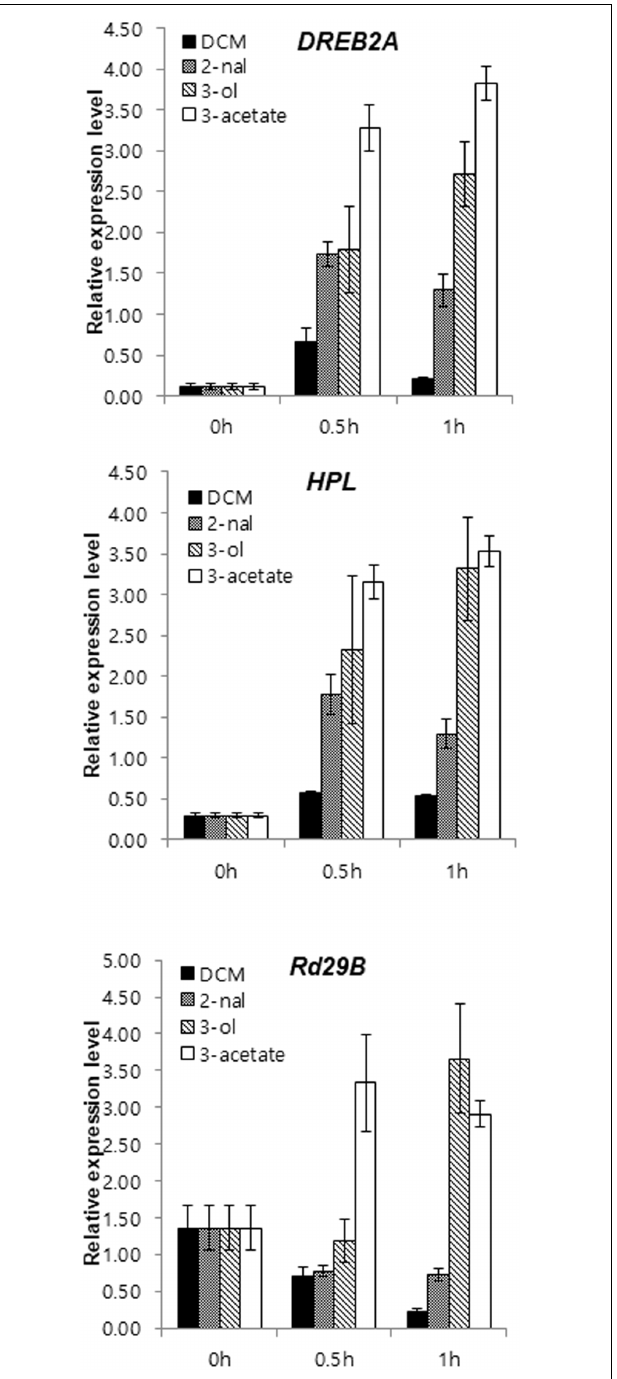
FIGURE 7 | Expression levels of abiotic stress-related genes in N. benthamiana were upregulated in response to GLV treatments. Gene expression is presented as relative transcript abundance of N. benthamiana leaves (WT) treated with 2 µ L 0.1 M DCM, E -2-hexenal, Z -3-hexenol, or E -3-hexenyl acetate for 30 and 60 min. Error bars indicate the standard deviation of three technical replicates, and the results were consistent in two biological replicates. The EF1 α gene was used as a reference gene. HPL , hydroperoxide lyase; DREB2A , dehydration-responsive element binding protein 2a; RD29B , responsive to desiccation 29.